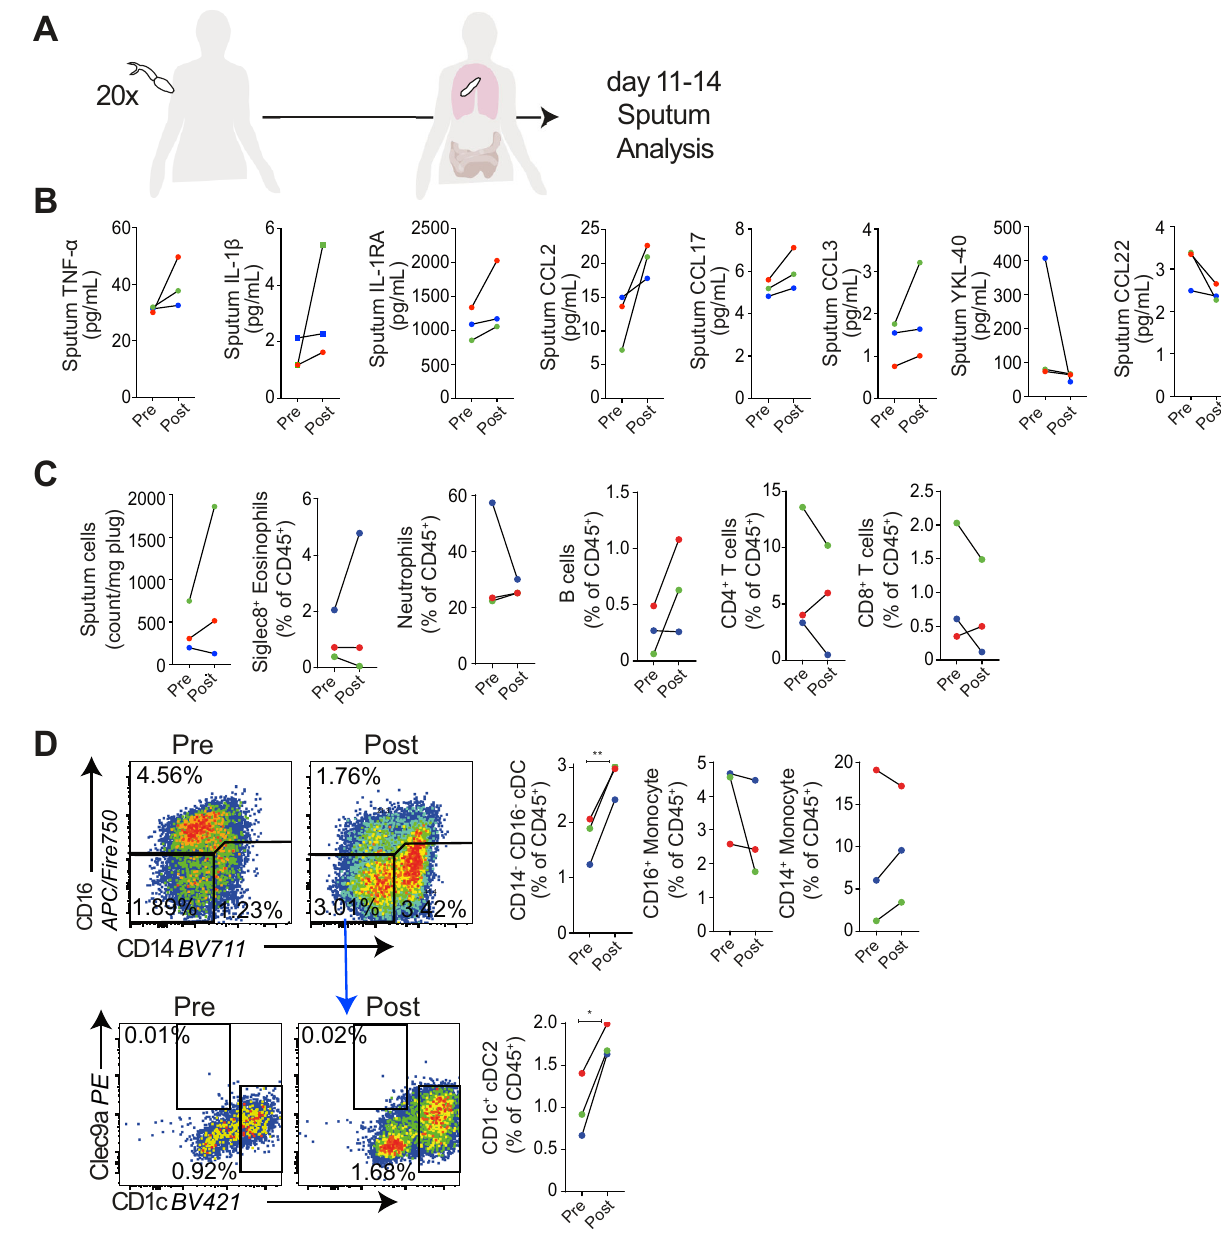
Fig.1 |Mixedin fl ammatoryresponses,andexpansionofsputumcDC2sduring pre-patent (lung migratory) schistosome infection of non-endemic partici- pants.A Pulmonaryresponseswerestudiedinnon-endemicparticipantsinLeiden, The Netherlands infected percutaneously with 20 S. mansoni cercariae, with induced sputum samples taken pre-infection, and 11 – 14 days post-infection. B In fl ammatory mediators in sputum supernatants were assessed by Luminex and ELISA. C Sputum cells were isolated, and assessed by fl ow cytometry for